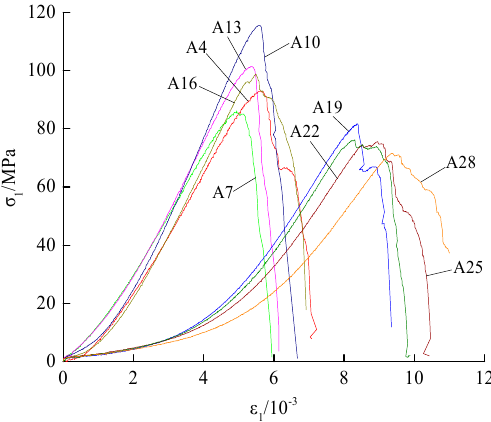
Figure 8. Complete stress–strain curves of one sample at same temperature under uniaxial compression.